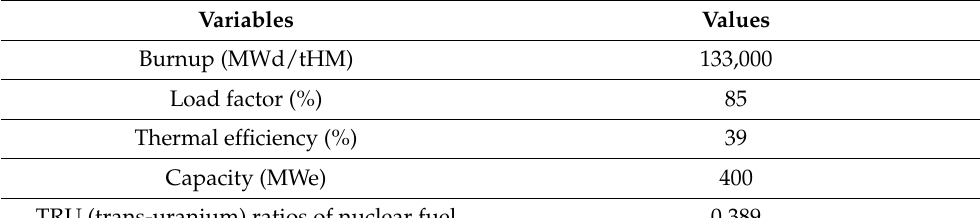
Table 5. SFR specifications.